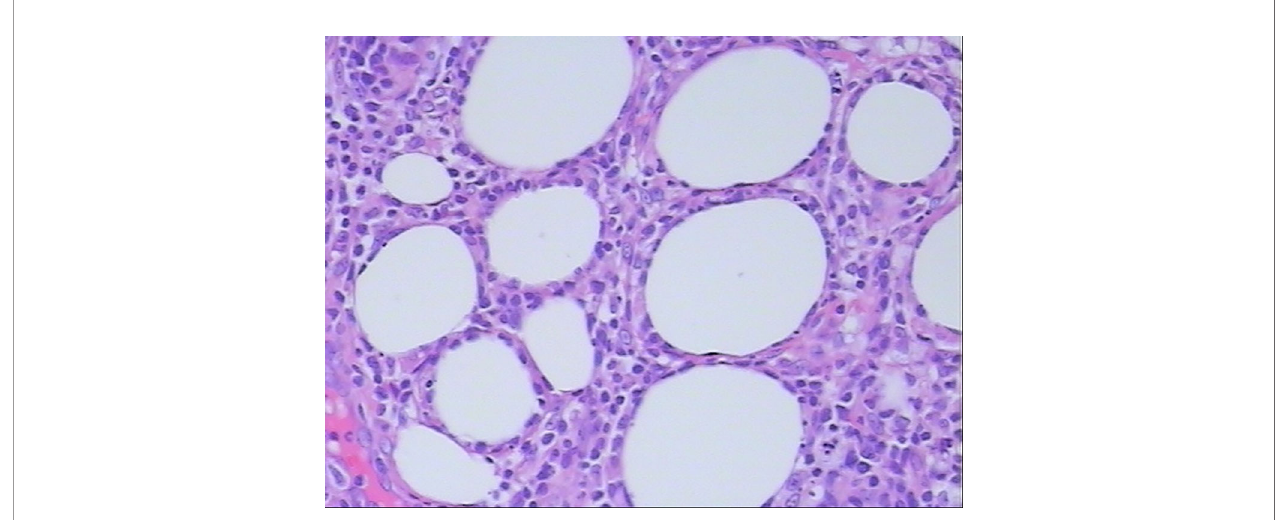
FIGURE 2 | Histopathological examination shows atypical lymphocyte rimming of individual adipocytes (hematoxylin and eosin, 400×).